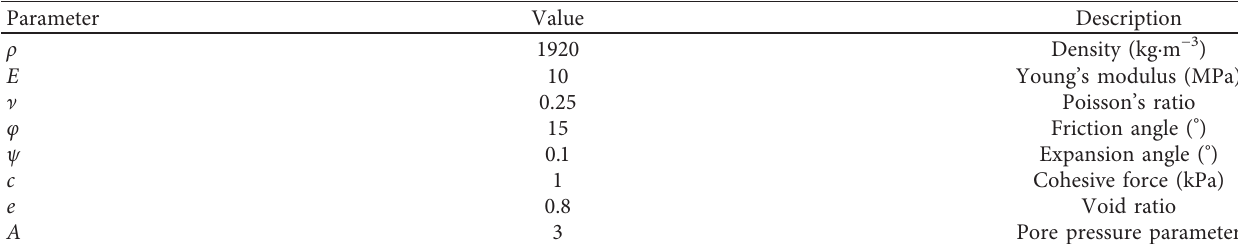
Figure 3: Numerical model of drilling process with mesh of the soil in detail. Table 1: Parameters of silty